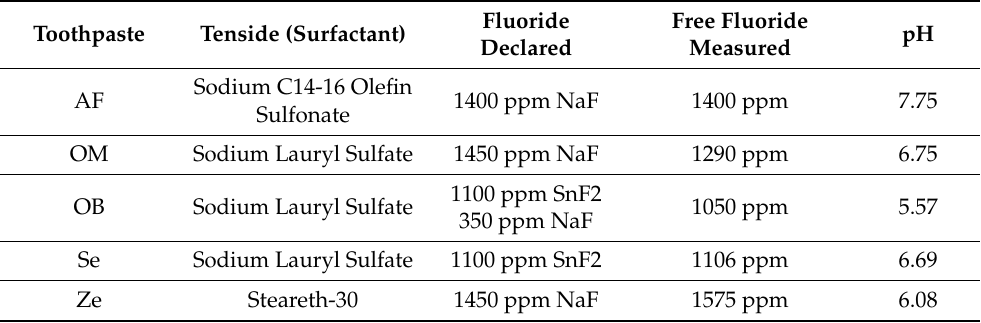
Table 1. Toothpastes and the respective surfactants, amount of declared fluoride concentration, amount of free fluoride measured, and